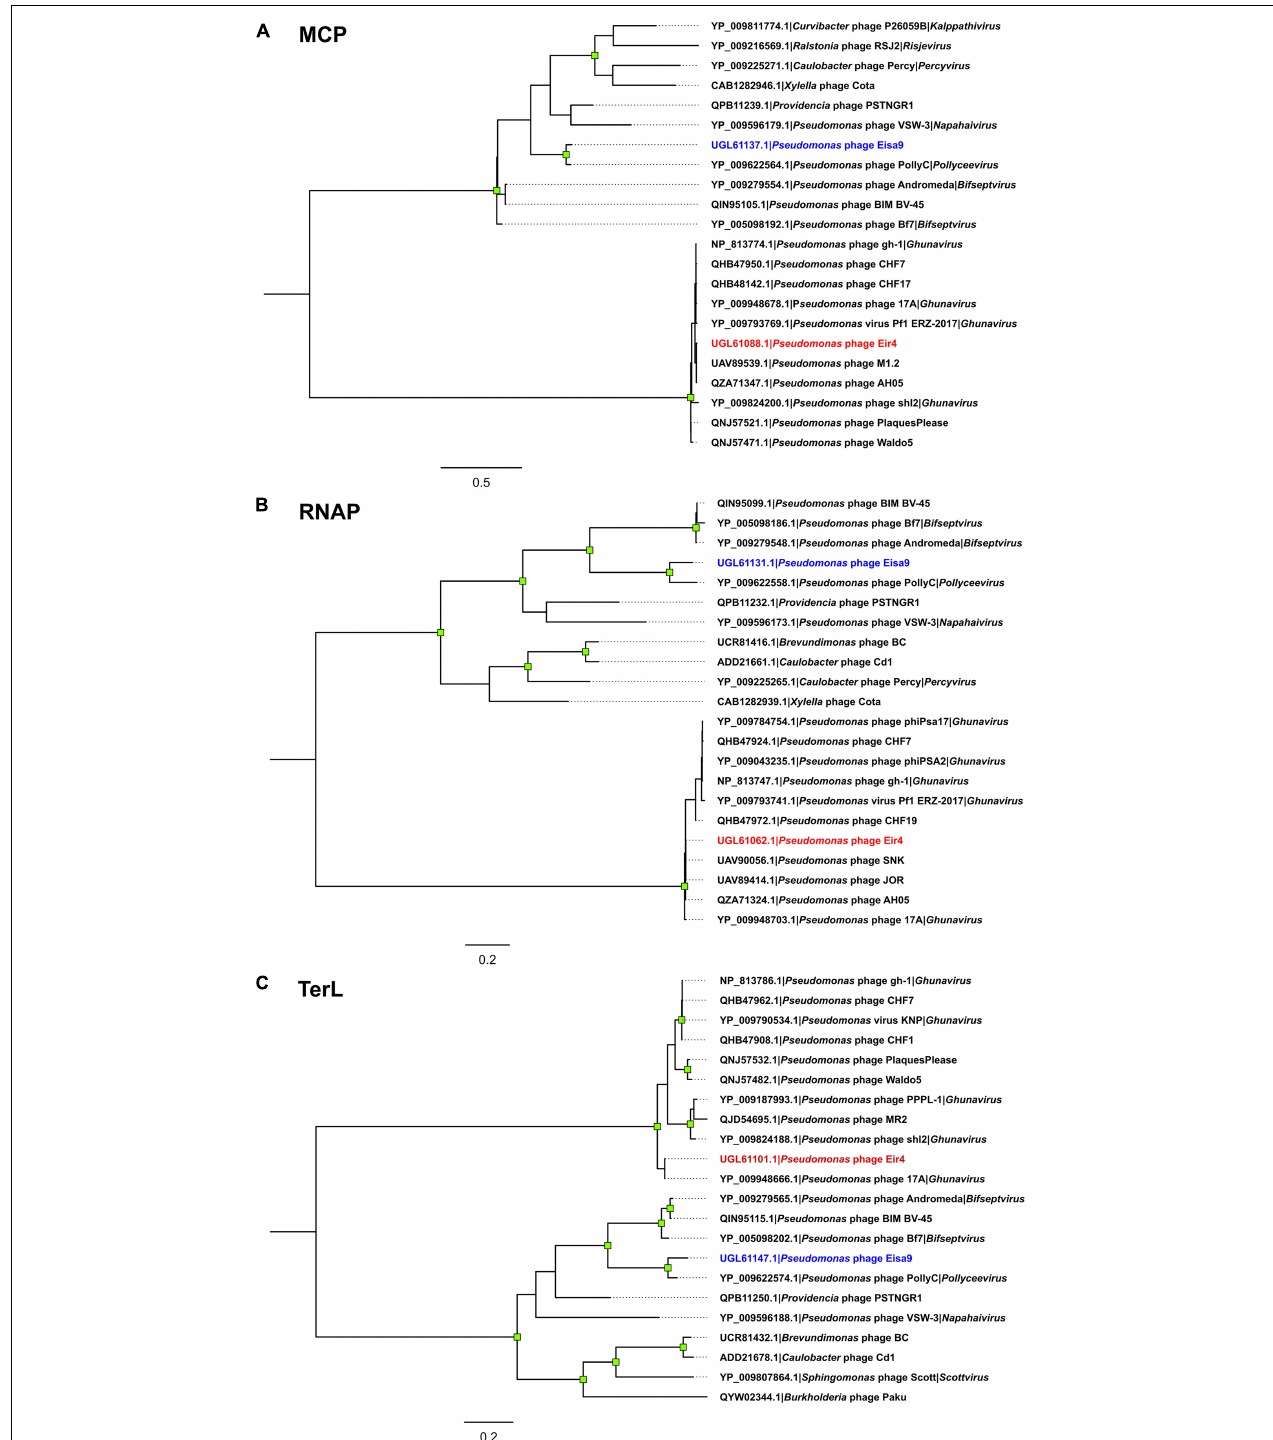
FIGURE 3 | Maximum-likelihood trees of the selected Pseudomonas phage Eir4 and Eisa9 protein amino acid sequences and the 10 most related sequences found in the proteomes of other completely sequenced phages: (A) major capsid protein; (B) DNA-dependent RNA polymerase; (C) terminase large subunit. All the trees are drawn to scale, and branch lengths correspond to the number of amino acid differences per site. Tips are labeled as “protein accession | originating phage | genus phage belongs to (if it is currently recognized by the official phage taxonomy),” labels of the tips representing the amino acid sequences of Eir4 and Eisa9 proteins are colored in blue and red, respectively. The trees are midpoint rooted, and the distal nodes of branches with ≥ 95% ultrafast bootstrap support (out of 1,000 replicates) are indicated by green squares.